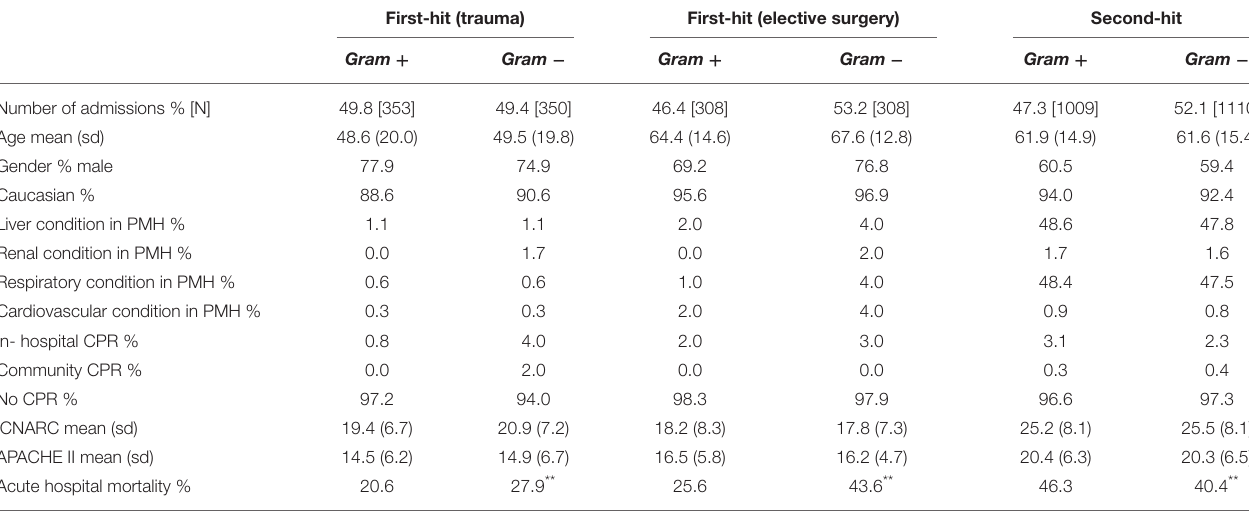
TABLE 1 | Baseline patient characteristics from the ICNARC dataset according to infecting organism type. First-hit (trauma) First-hit (elective